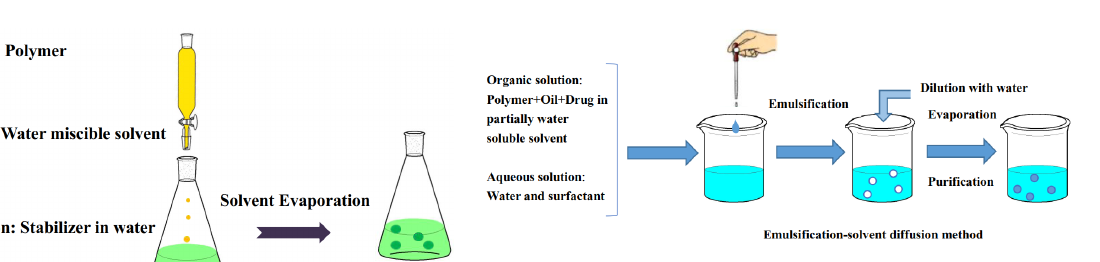
Figure 2: Schematic representation of the emulsification-solvent diffusion method for the preparation of nanoparticles other at room temperature and afterwards diluted with a large amount of water to induce the diffusion of the sol- vent from dispersed droplets into the external phase. This results in the formation of particles [30]. The advantages of this method include enhanced encapsulation efficiency, easy enlargement, narrow size distribution, and